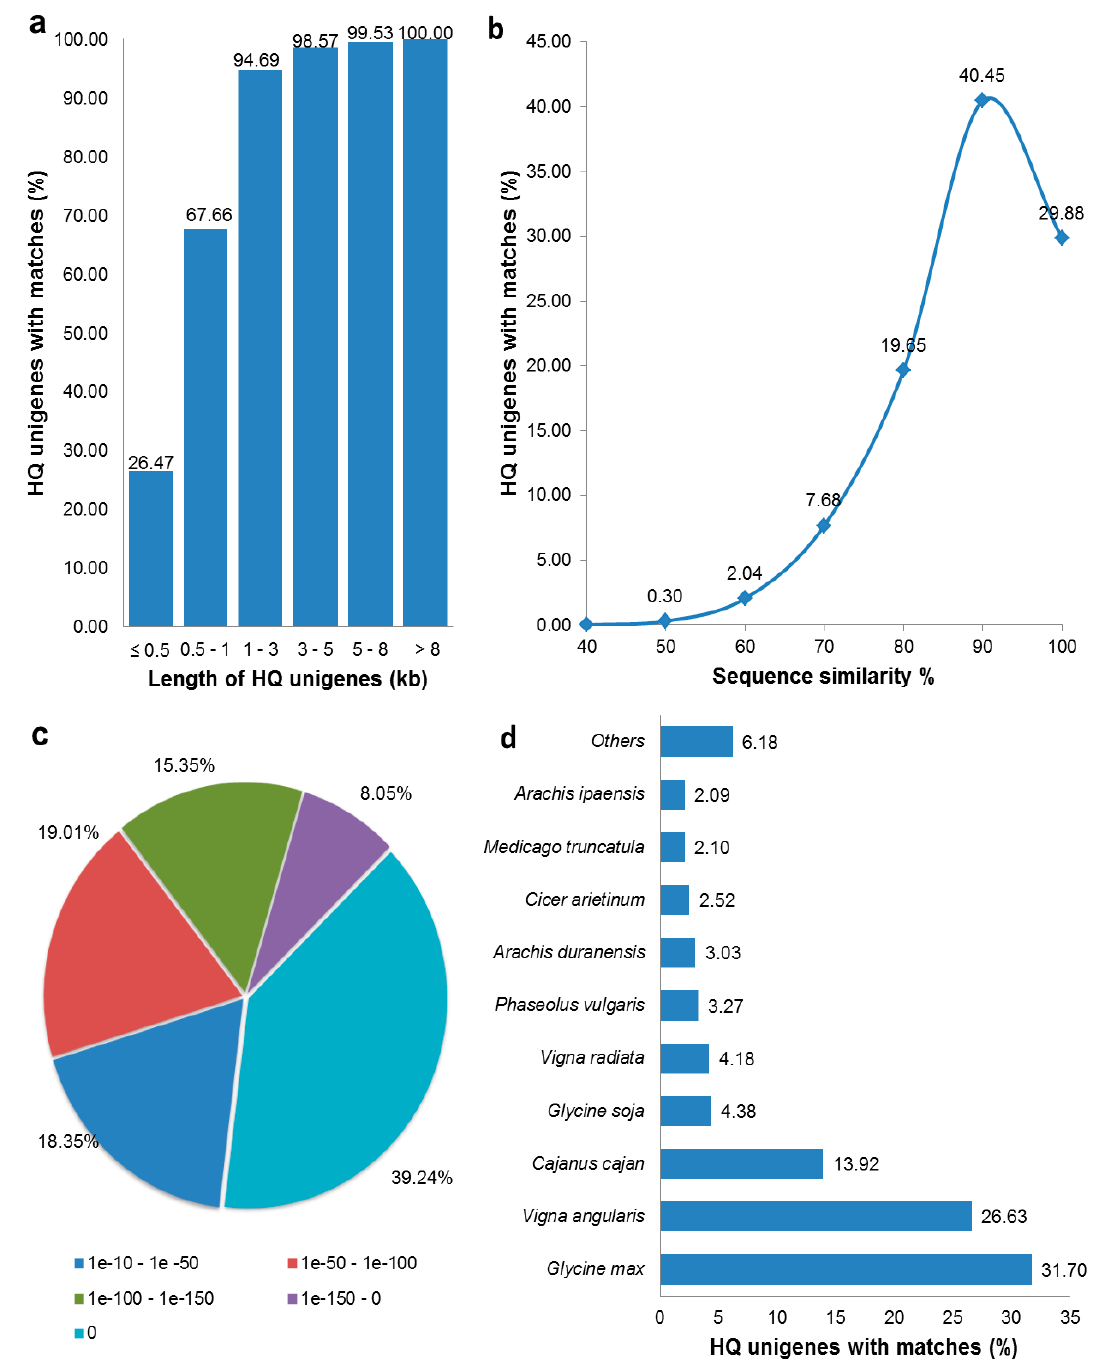
Figure 1. Statistics of BLAST search results of HQ Unigenes against Plant-genes database. ( a ) Length-wise distribution of HQ unigenes (query) sequence with significant matches ( E -value ≤ 1 × 10 − 10 ). A very high proportion (>98%) of large unigenes (>3 kb) showing significant matches; ( b ) similarity distribution of the best BLAST hits for each of the unigene with significant matches showing that 70.33% these having sequence similarity from 80 to 100%; ( c ) percent distribution of HQ unigenes on the basis of their E -values; ( d ) species distribution showing percentage of the HQ unigenes (query) sequence with significant matches against different species with maximum (31.70%) of these were having top BLAST hits against Glycine max.